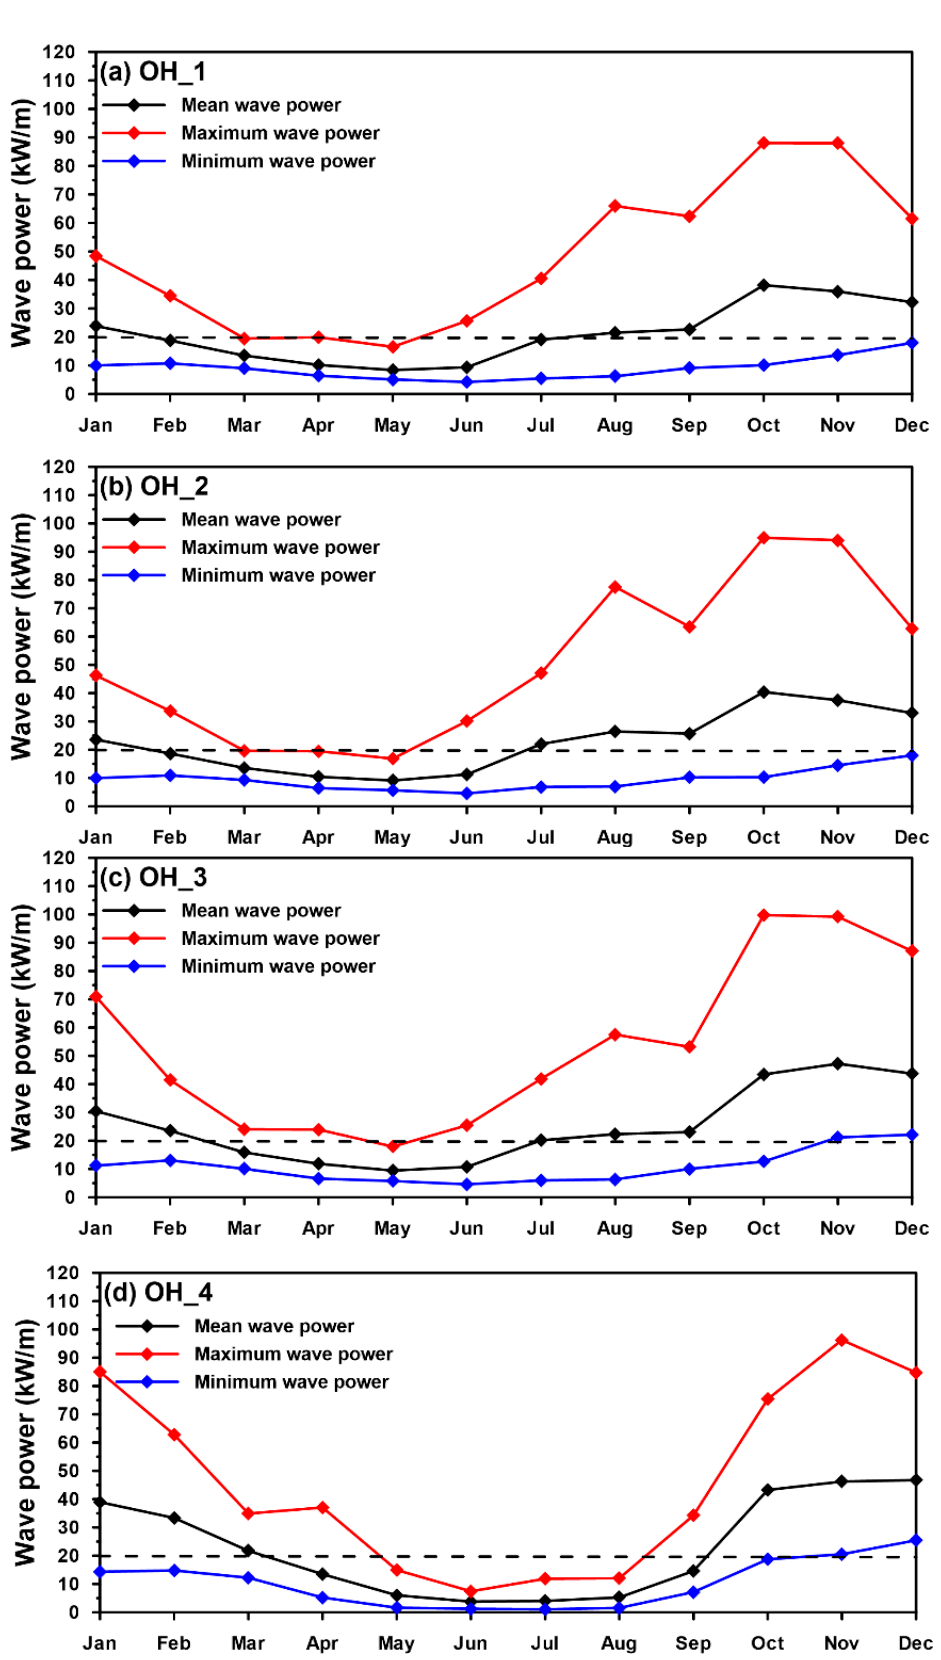
Figure 15. Monthly mean, maximum and minimum wave powers from 1991 to 2010 for four optimal wave energy hotspots: ( a ) OH_1, ( b ) OH_2, ( c ) OH_3, and ( d ) OH_4.